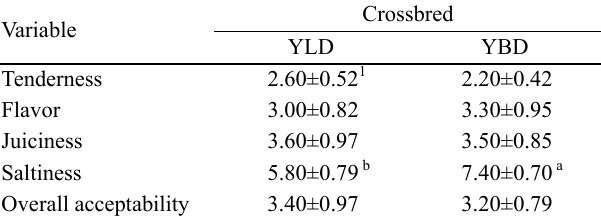
Table 4. Sensory evaluations of dry-cured ham made from two different three-way crossbreed pigs